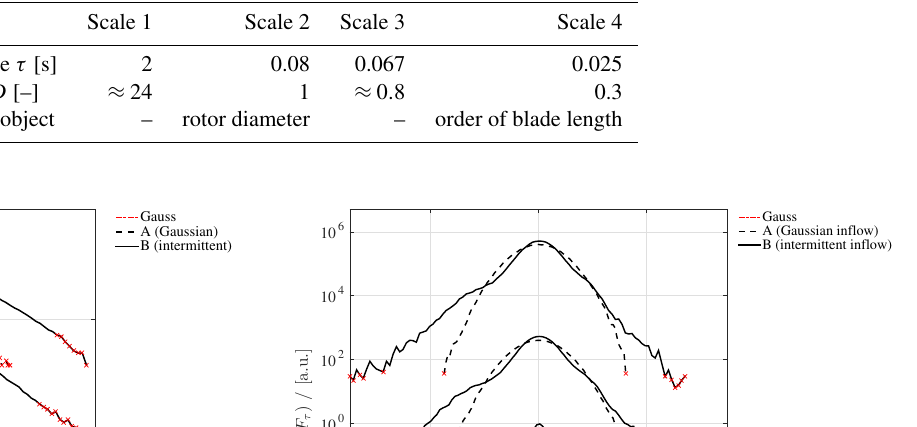
Table 2. Overview of scales considered in relation to certain characteristic turbine lengths. The timescales τ were used in the analyses. To get an idea of the spatial dimension, Taylor’s hypothesis is used to transfer from time to space with (cid:104) u (cid:105) ≈ 7ms − 1 . The obtained length scales are expressed as multiples of the rotor diameter for better comparison. The lengths are further related to physical objects of the turbine to get a sense of the dimensions.